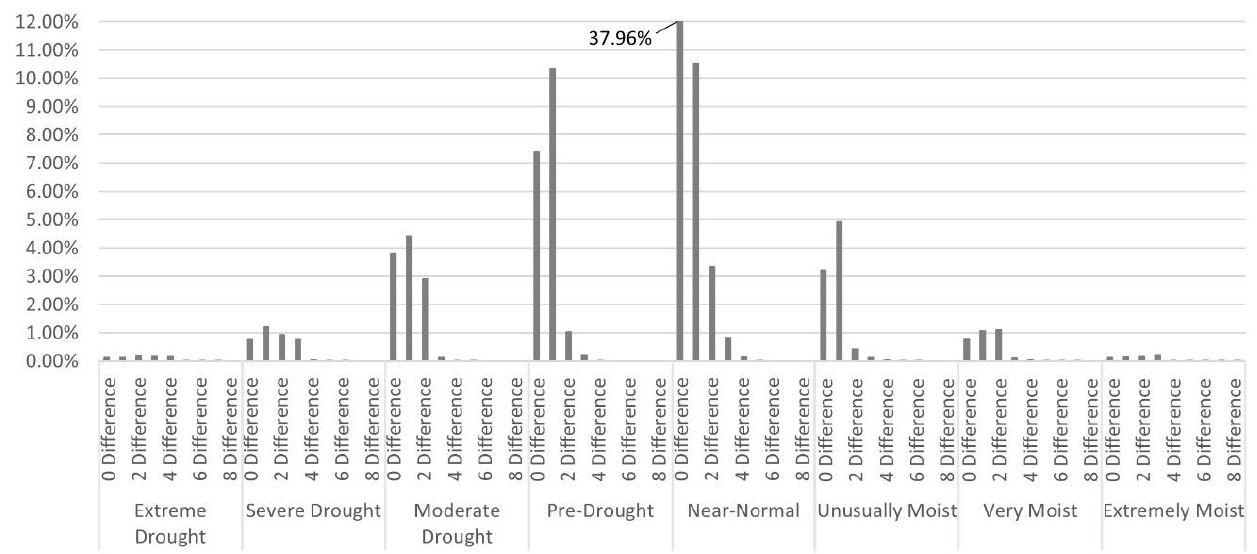
Figure 6. Total pixel classification difference between transformed expedited Visible Infrared Imaging Radiometer Suite (eVIIRS’) and expedited Moderate Resolution Imaging Spectroradiometer (eMODIS) Vegetation Drought Response Index (VegDRI). For example, 37.96% of pixels were classified by eVIIRS’ as “near-normal” and were classified as the same by eMODIS, and 10.53% of the pixels called “near-normal by eVIIRS’ were within 1 class in eMODIS. The percentage is based on all pixels not including changes in the Out-of-Season or water classification for all four weeks (29,131,856 pixels).